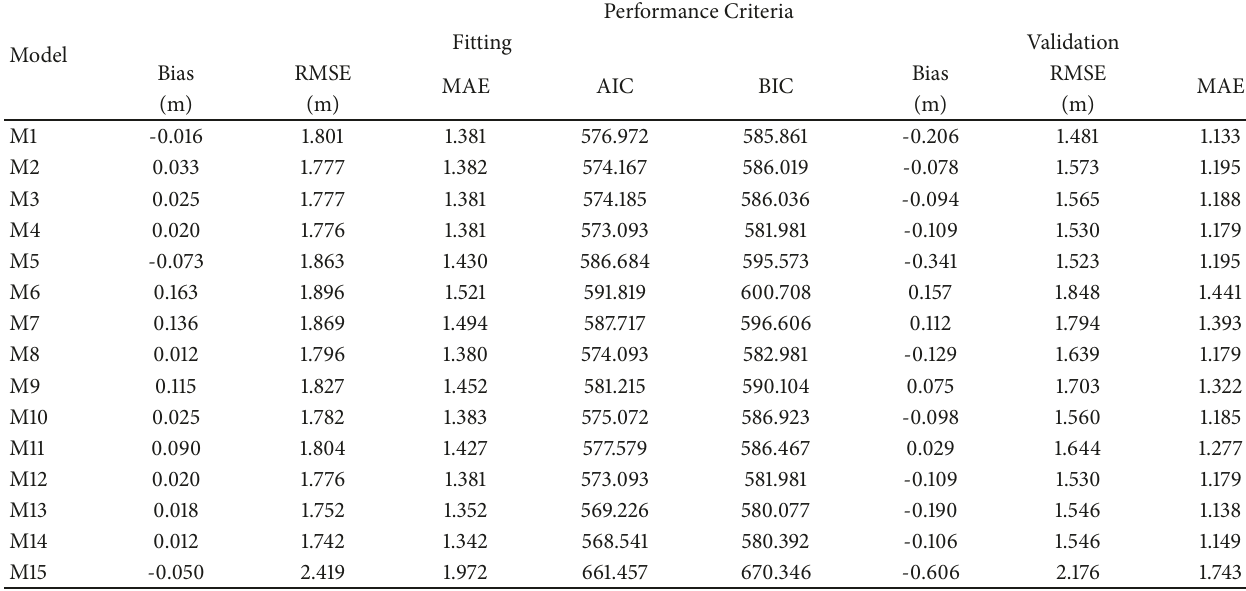
Table 4: Performance statistics of selected models for fitting and validation dataset.